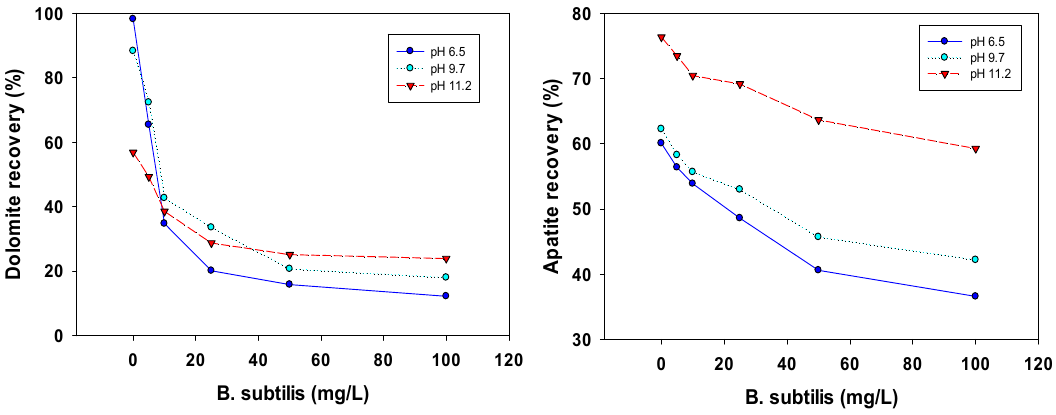
Figure 3. Effect of B. subtilis on dolomite (depression) and apatite in the presence of 10 mg/L sodium oleate as a collector